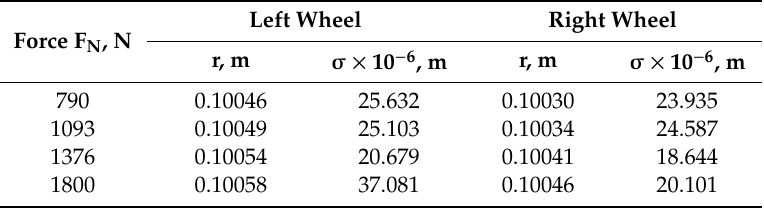
Table 1. Average values and standard deviations in the individual measurement series.